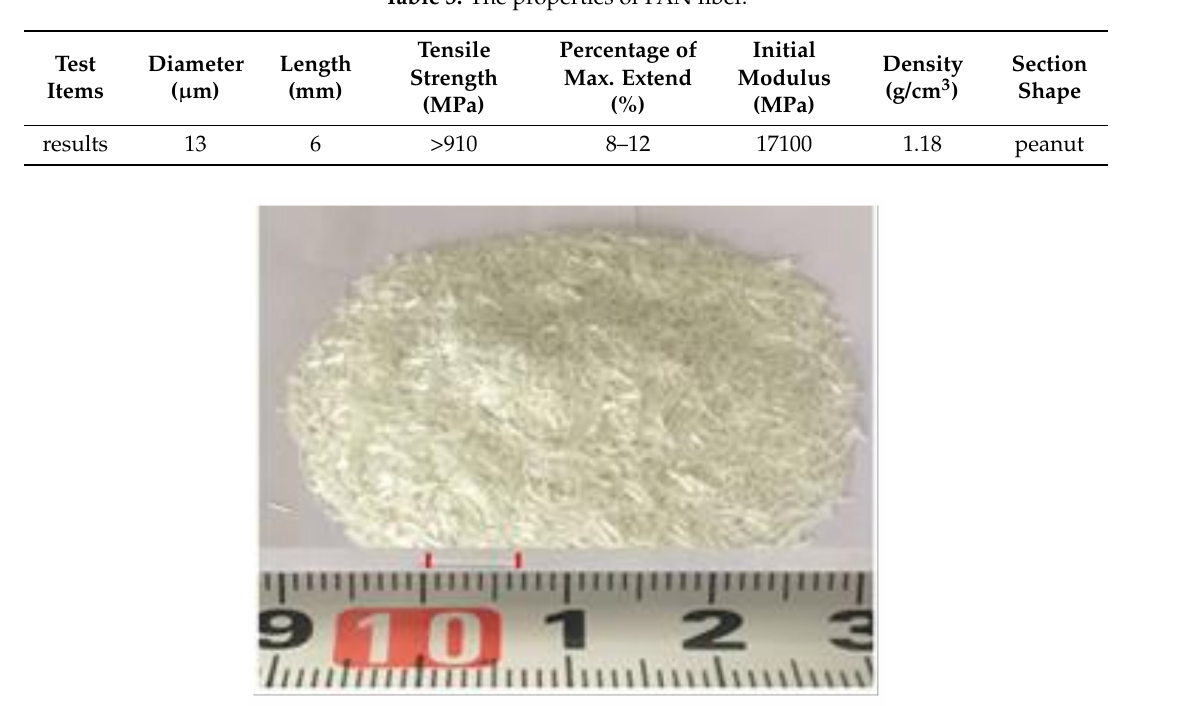
Table 3. The properties of PAN fiber.